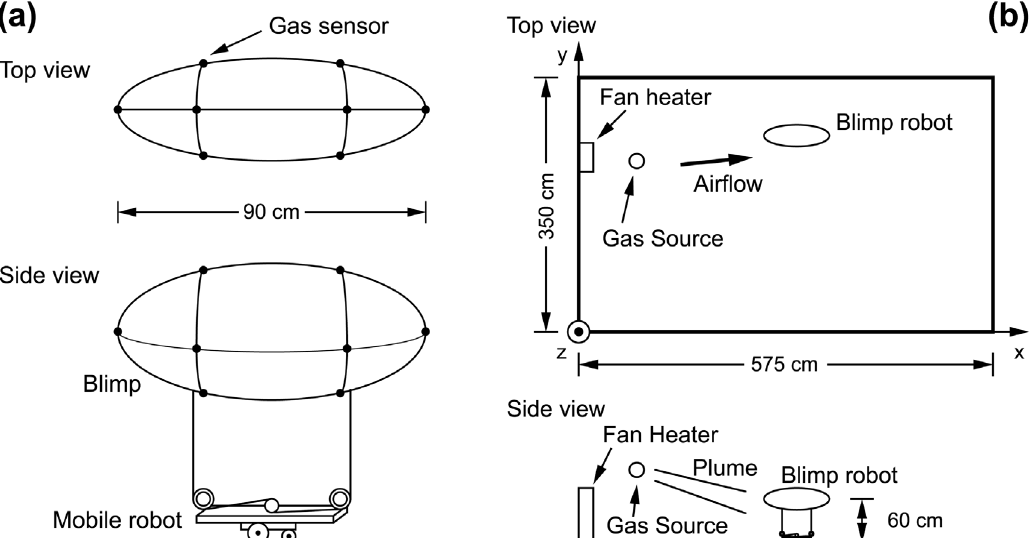
Figure 17 . (a) Schematic diagram of the blimp-based robot used for three-dimensional gas source tracing experiments by Ishida et al. [86]. (b) Sketch of the corresponding experimental